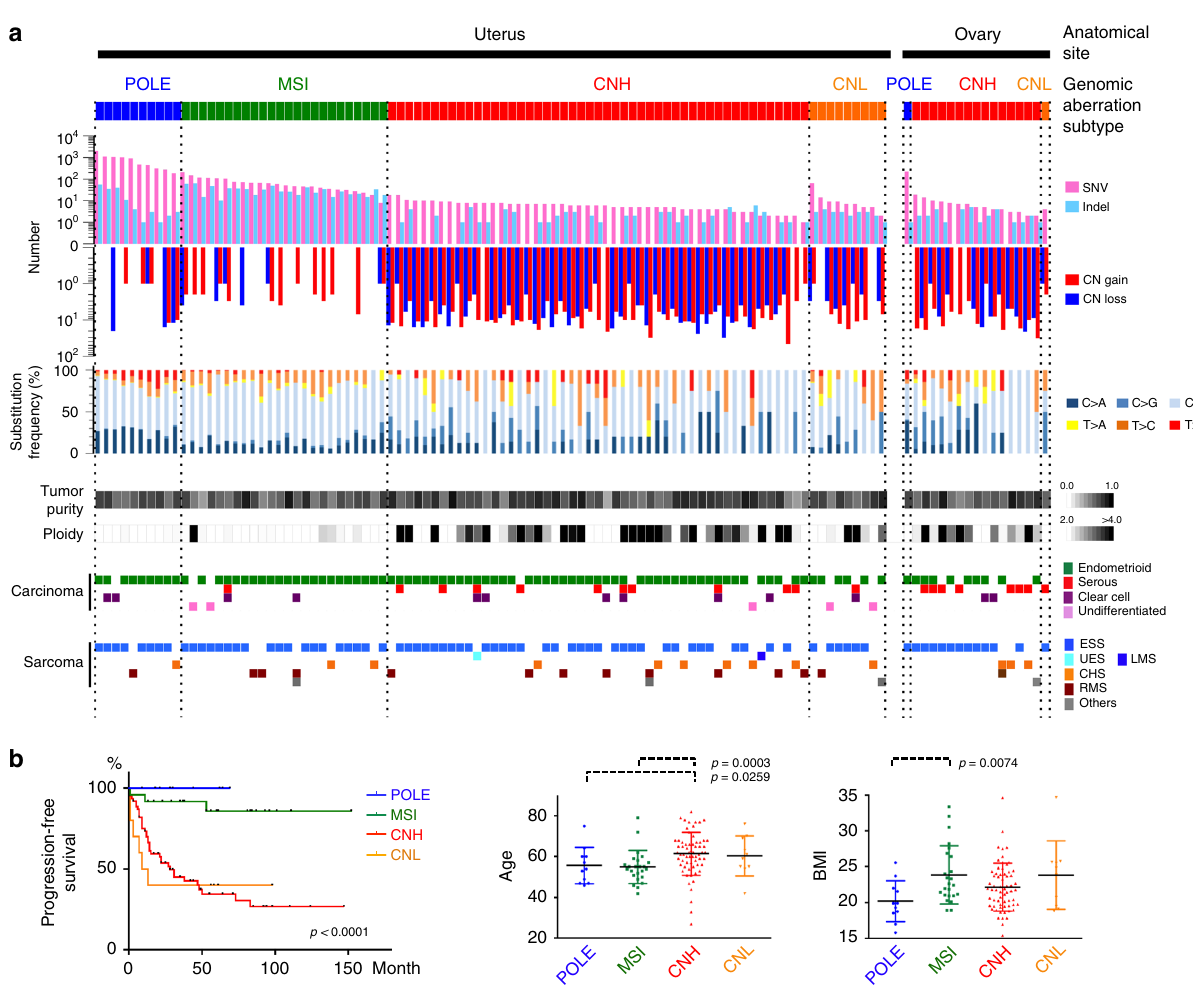
Fig. 1 Genomic aberration pro fi ling identi fi ed four molecular subtypes that correlate with various clinicopathological features. a Patterns of genomic alterations in carcinosarcoma (CS) genomic aberration subtypes (MSI, POLE, CNH, and CNL). Uterine (92) and ovarian (17) samples were sorted according to the number of SNVs within a subtype. Panels from top to bottom: bar plots for number of SNVs (pink) and indels (pale blue); bar plots for number of segments with copy-number aberration (CN gain, red; CN loss, blue); rates in percent of nucleotide substitutions (C > A, indigo; C > G, navy blue; C > T, sky blue; T > A, yellow; T > C, orange; T > G, vermilion); tumor purity; tumor ploidy; histopathological diagnosis of carcinoma components (endometrioid, green; serous, red; clear cell, violet; undifferentiated, pink); and histopathological diagnosis of sarcoma components (ESS, sky blue; RMS, brown; CHS, yellowish brown; others, gray). POLE, POLE -mutated; MSI, microsatellite instability; CNH, copy number high; CNL, copy number low; SNV, single nucleotide variant; CNV, copy number variant; CN, copy number; ESS, endometrial stromal sarcoma; RMS, rhabdomyosarcoma; CHS, chondrosarcoma. b Clinical relevance of CS genomic aberration subtypes. Statistically signi fi cant parameters are shown among CS genomic subtypes. Left panel. Relapse-free survival in Kaplan – Meier curve. P -values were computed with log-rank test. Middle panel. Age. P -values were computed with the Mann – Whitney U -test. Right panel. Body mass index (BMI). P -values were computed with the Mann – Whitney U -test. Bars and error bars indicate